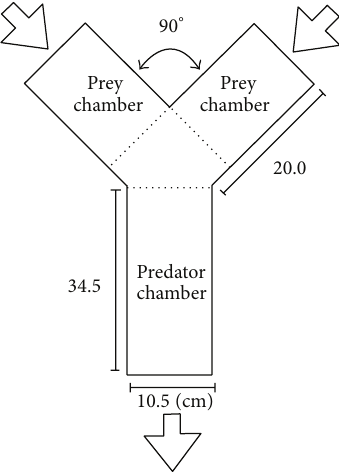
Figure 1: Schematic diagram of the 𝑌 -maze. Open arrows indicate thedirectionofwaterflow.Dimensionsareexpressedincentimeters. Components are not drawn to